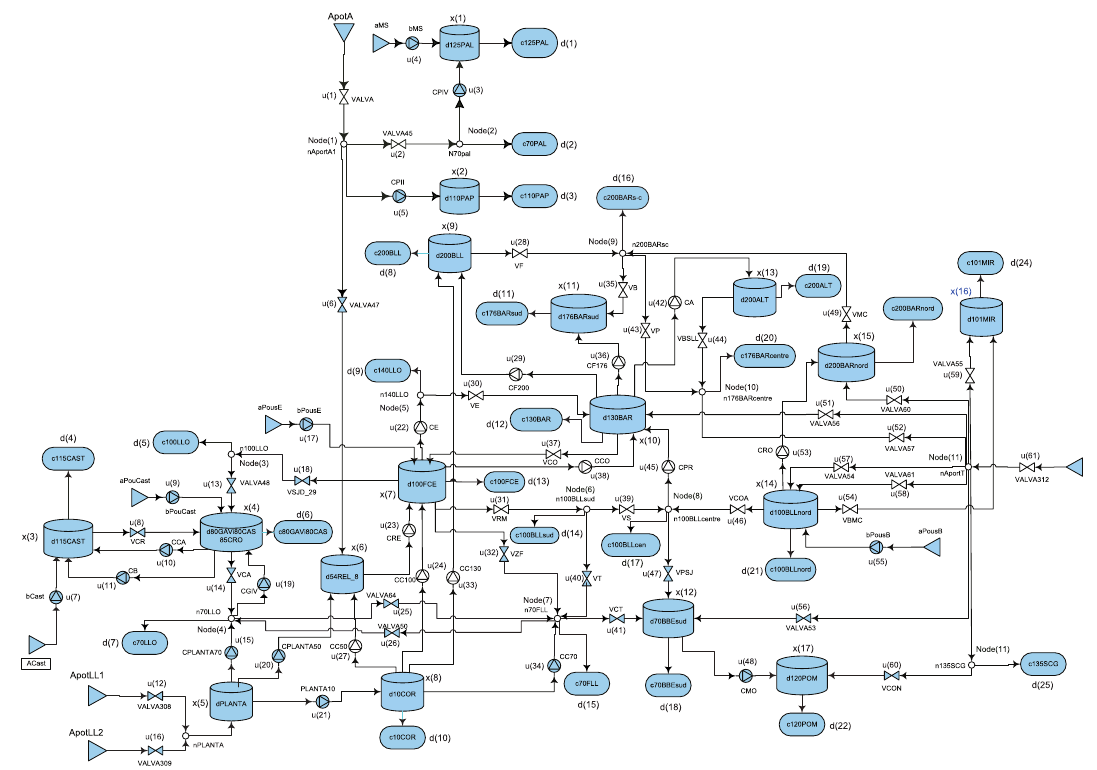
Figure 2. Barcelona drinking water